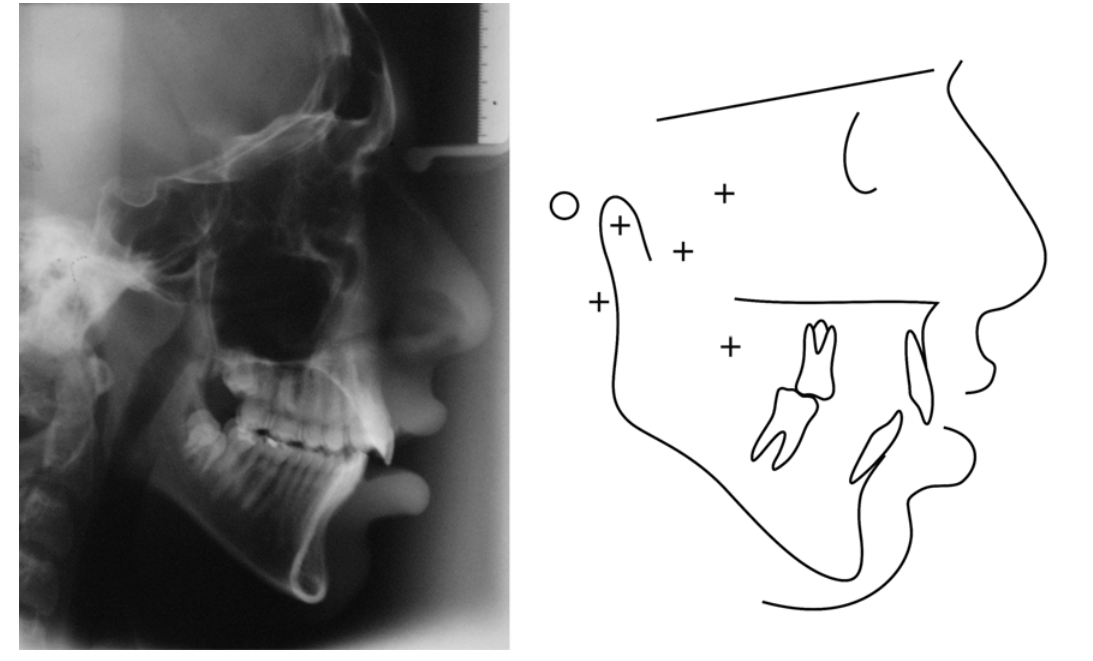
FIGURE 3- Pretreatment headfilm and cephalogram